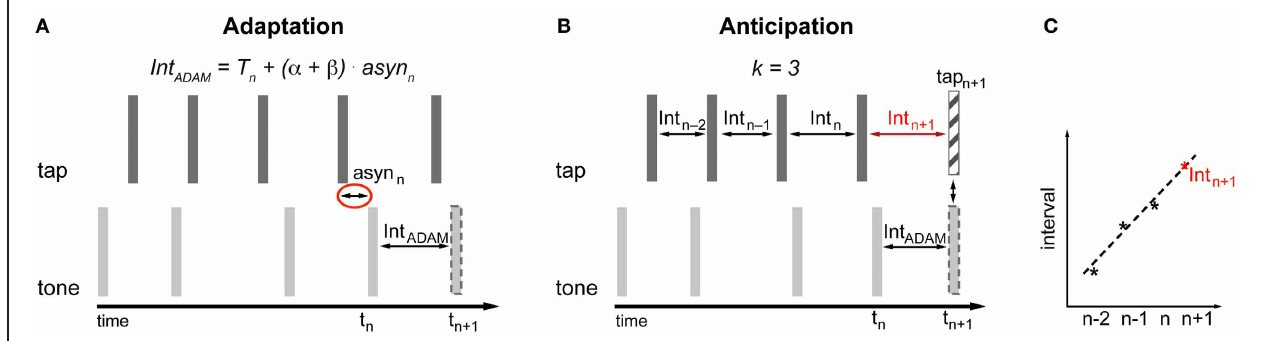
ADAM between t n and t n + 1 is equal to T n + ( α + β ) × asyn n . (B,C) A curve-fitting process that is applied to the preceding intervals predicts the participant’s next tap time (Equations 3 and 4). The timing of upcoming tone or the next interval produced by ADAM can be set to enable ADAM’s next tone to coincide with the predicted next tap of the